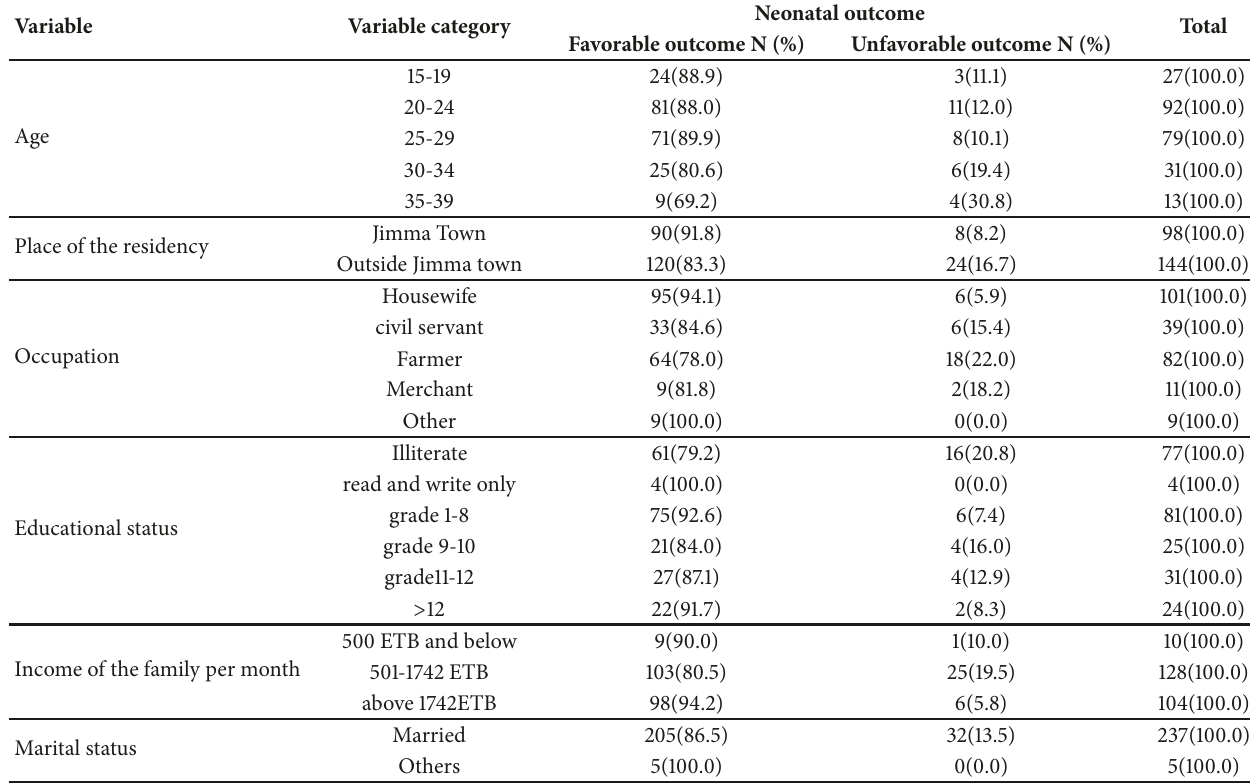
Table 3: Distribution of neonatal outcome among different maternal sociodemographic characteristic categories who gave birth by OVD in JUMC December 1, 2016–May 30,